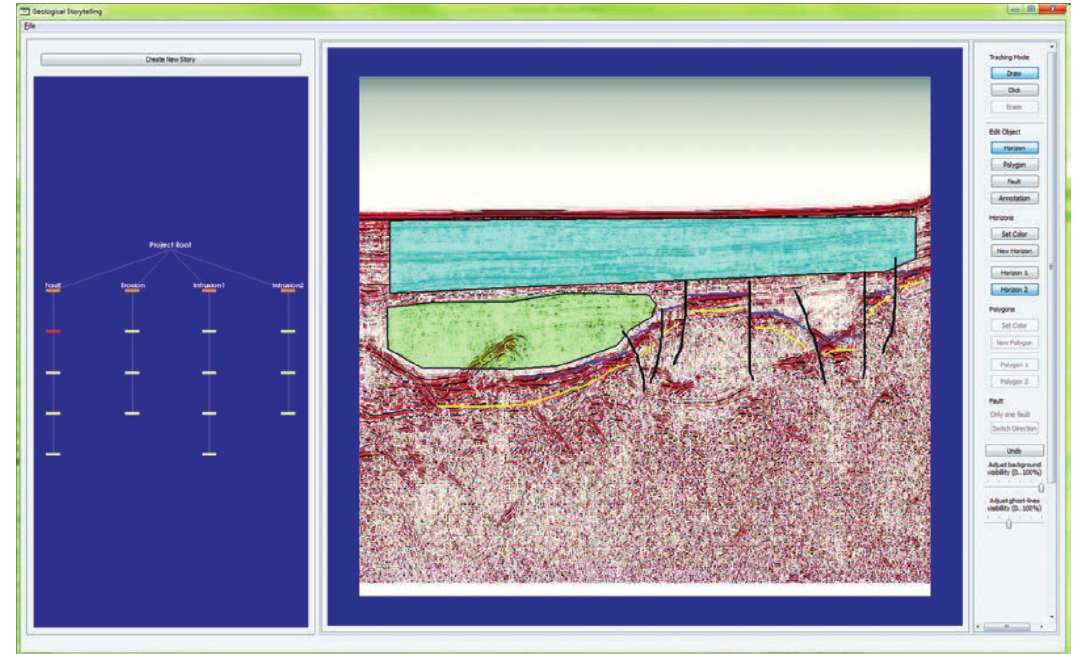
Figure 7. Lidal et al. [3,21] present a sketch-based interface for rapid modelling and exploration of various geological scenarios. The sketch-based interface is split into two windows. The Story Tree ( left ) which shows a tree graph representation of all the geological stories, and the Canvas ( right ) which shows the sketching interface which utilises a pen and paper interaction to record geological sedimentary data. A geological story is built using horizontal lines to separate different geological layers, vertical lines to show fault systems, and polygons for highlighting large sedimentary layers.